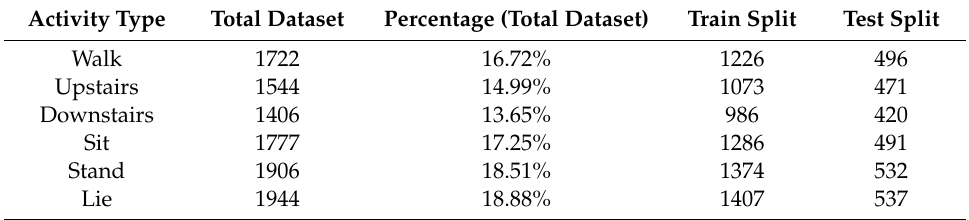
Table 2. Overview of the physical activity classification systems developed using boosting